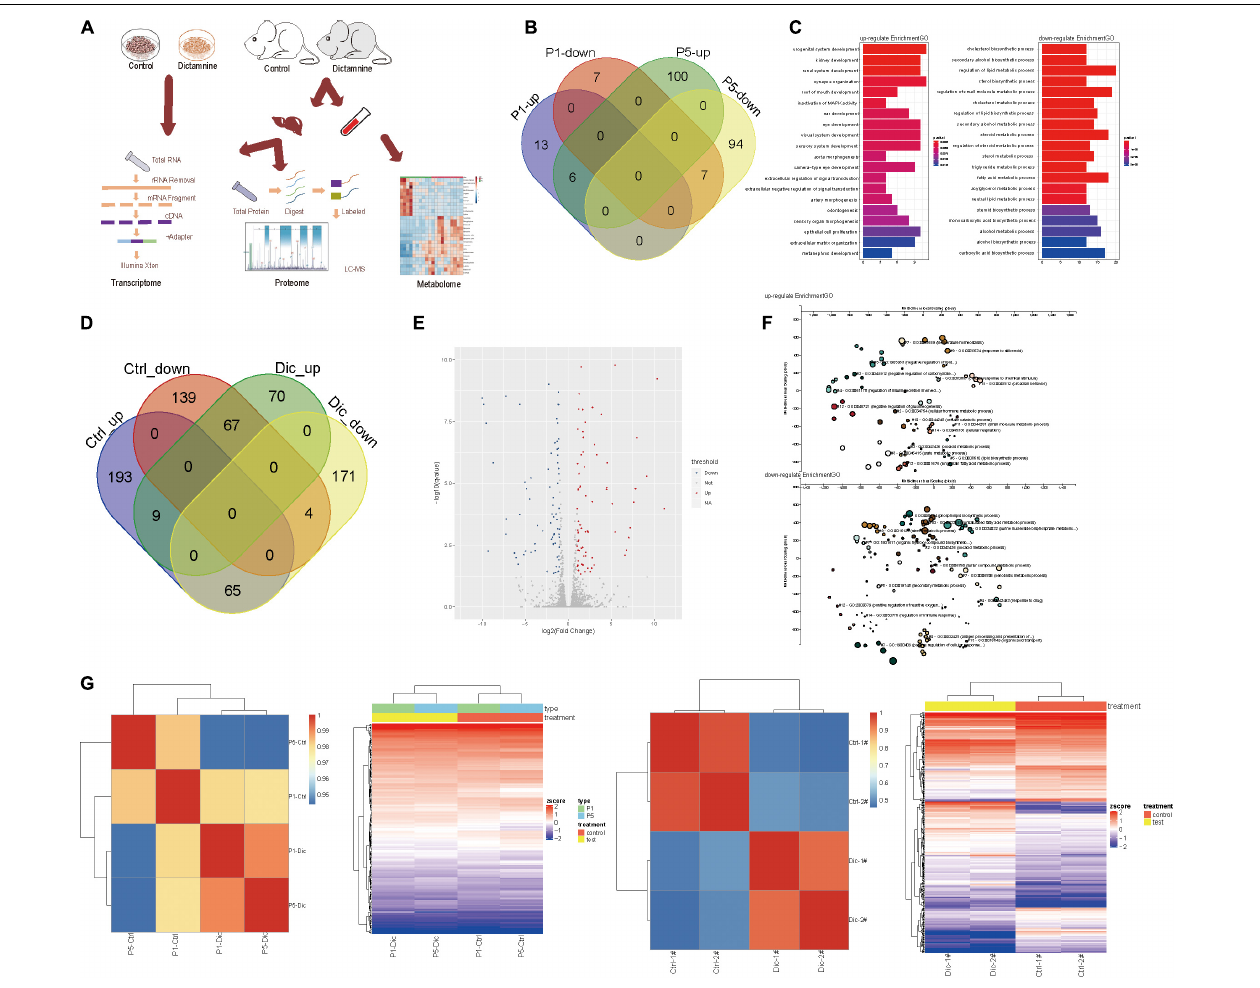
FIGURE 2 | Transcriptome analysis of dictamnine-induced hepatotoxicity in vitro and in vivo. (A) Overview of methodology, animal samples collection (serum and liver tissue) and analyses. (B) Veen diagram display up-regulated and down-regulated genes in hepatic cells treated with dictamnine concentrated in PI and P5 cells. (C) The enriched GO terms of the RNA-seq data of HepaRG cells treated with dictamnine concentrated in PI and P5 cells. (D) Veen diagram display up-regulated and down-regulated genes in dictamnine treated female and male mice. (E) The volcano map of differentially expressed genes in dictamnine-treated female mice. (F) The enriched GO terms of RNA-seq data of dictamnine-treated female ICR mice. (G) Heatmap showing the expression level of differentially expressed in HepaRG cells (P1 vs. P5) and ICR mice (Ctrl vs. Dic),